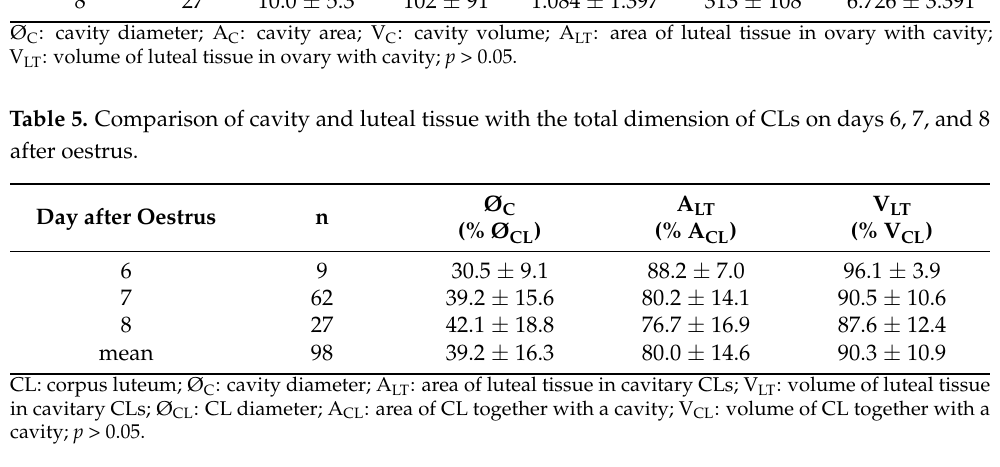
Table 4. Comparison of cavity and luteal tissue parameters on days 6, 7, and 8 after oestrus. Ø C Day after A C V C A LT V LT n Oestrus (mm) (mm 2 ) (mm 3 ) (mm 2 ) (mm 3 ) 313 ± 108 Ø C : cavity diameter; A C : cavity area; V C : cavity volume; A LT : area of luteal tissue in ovary with cav-